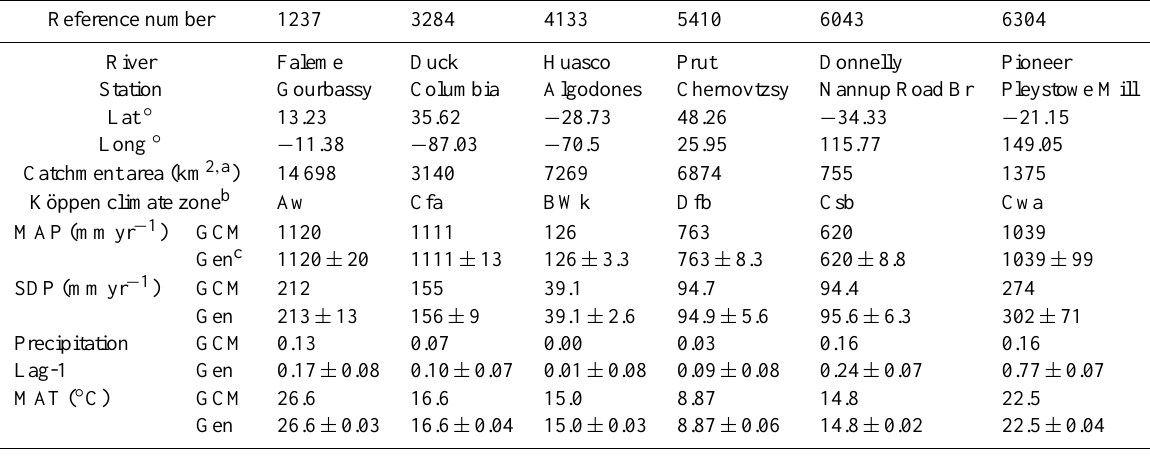
Table 1. Comparison between MIROCM(1) GCM estimates of mean and standard deviation of annual precipitation and mean annual tem- perature of 20C3M data and stochastically generated values for six worldwide catchments. Generated values are based on 100 replicates, each 151 years